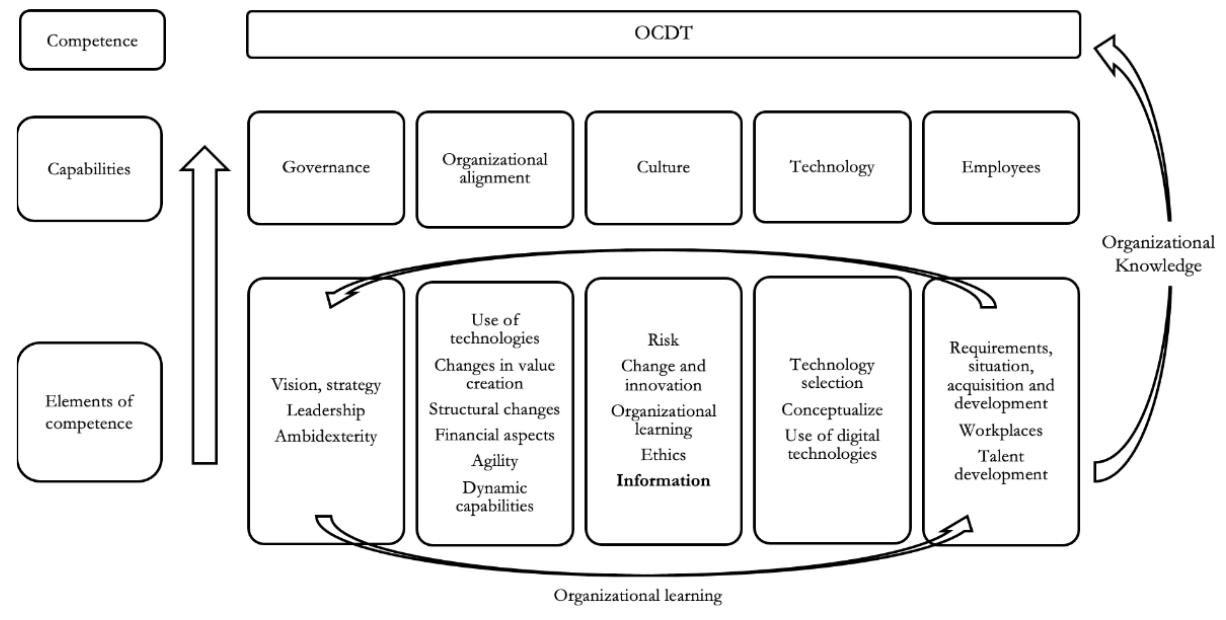
Figure 2. The refined model of Organizational Competence for Digital